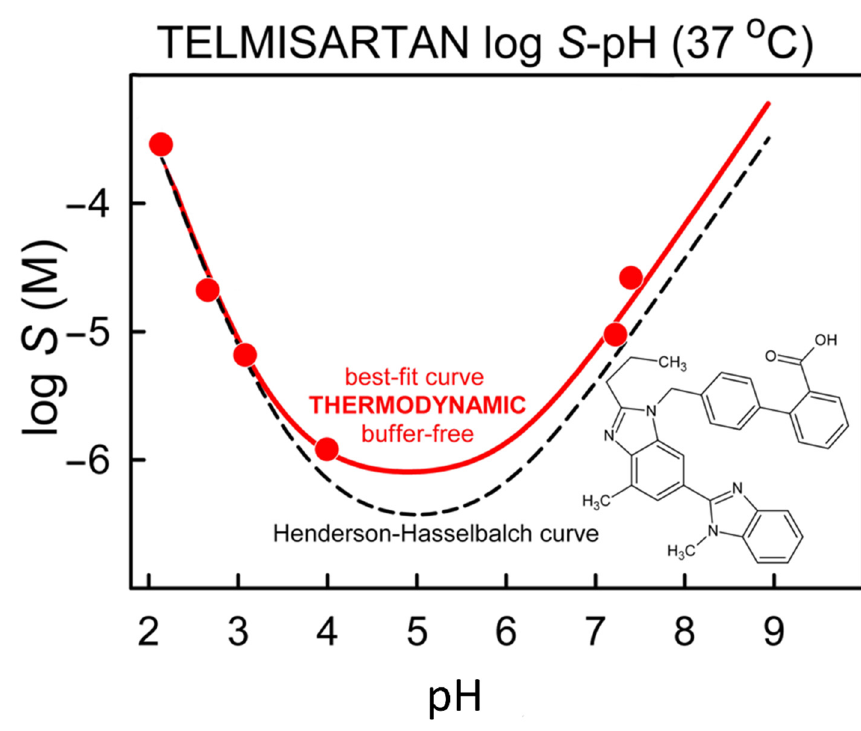
Figure 5. log S-pH profile of Telmisartan in distilled water at 37